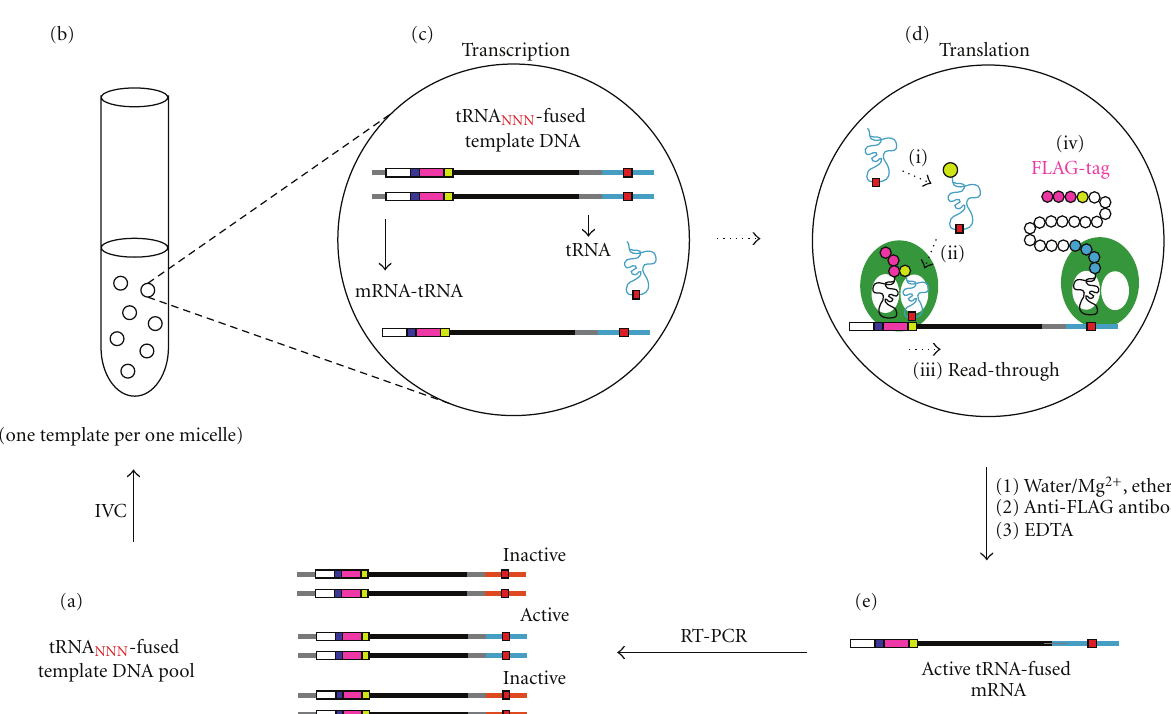
Figure 2: Rt-RD/IVC-based selection/amplification cycle. See the text for